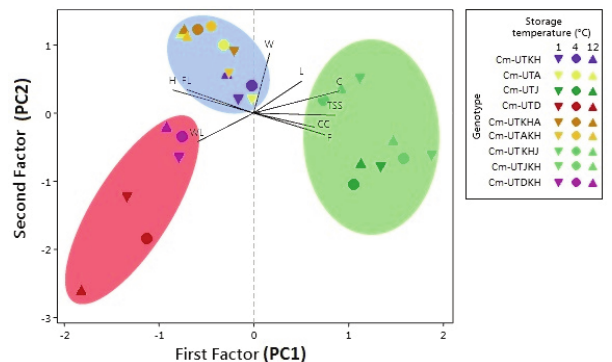
Table 3 ­ Principal component analysis unrotated factor load­